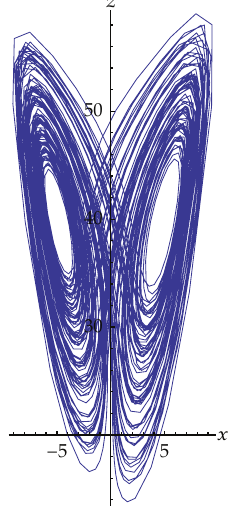
Figure 2: xz -phase portrait for α (cid:8) 0 . 97.